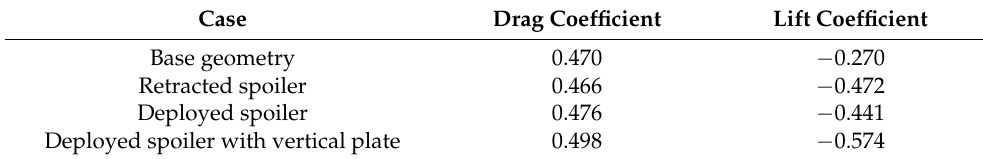
Figure 8. Contours of velocity (m/s) (left column) and pressure coefficient (right column) on the symmetry plane: ( a ) Base case geometry; ( b ) retracted splitter: ( c ) deployed splitter: ( d ) deployed splitter with a vertical plate. Table 3. Aerodynamic coefficients with the active